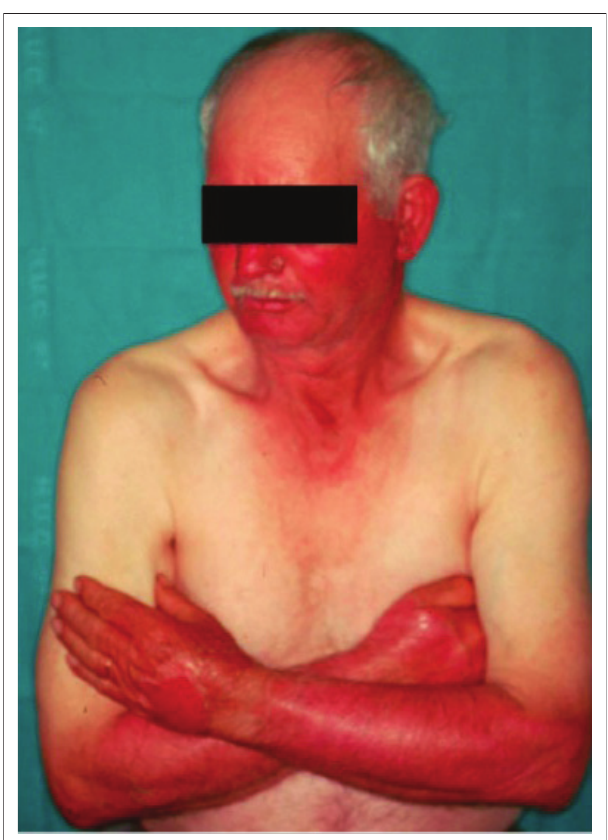
FIGURE 2: Phototoxic drug reaction.